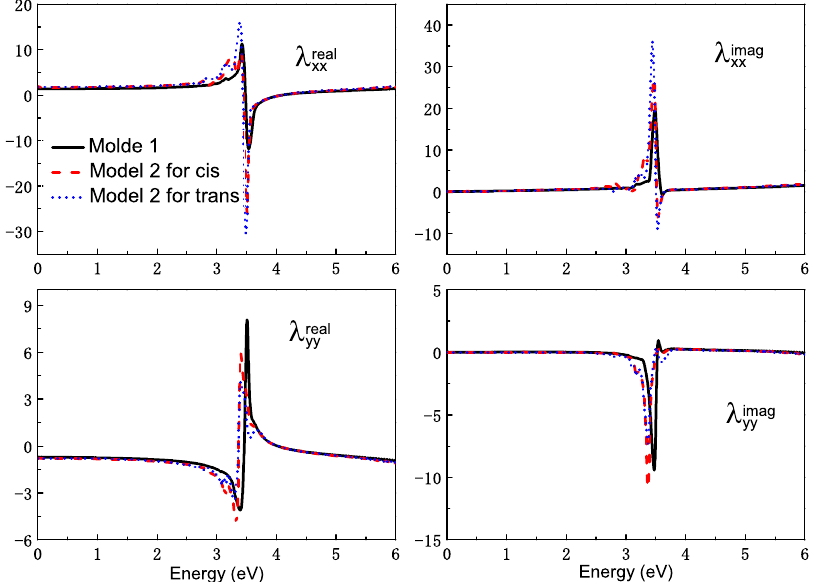
Figure 4. The real and imaginary parts of λ xx and λ yy on the surface of Ag NP. For the solid black line, the radius of Ag sphere is 5 nm, and the observed point is set at the center of mass of the azobenzene molecule. The dash red line and dot blue line show the SPR in model 2. The observed point is set at the center of mass of Ag20-cis azobenzene and Ag20-trans azobenzene complexes, respectively. AgNP is the remaining part of a 5 nm radius nanosphere that is gouged out of a tetrahedron in model